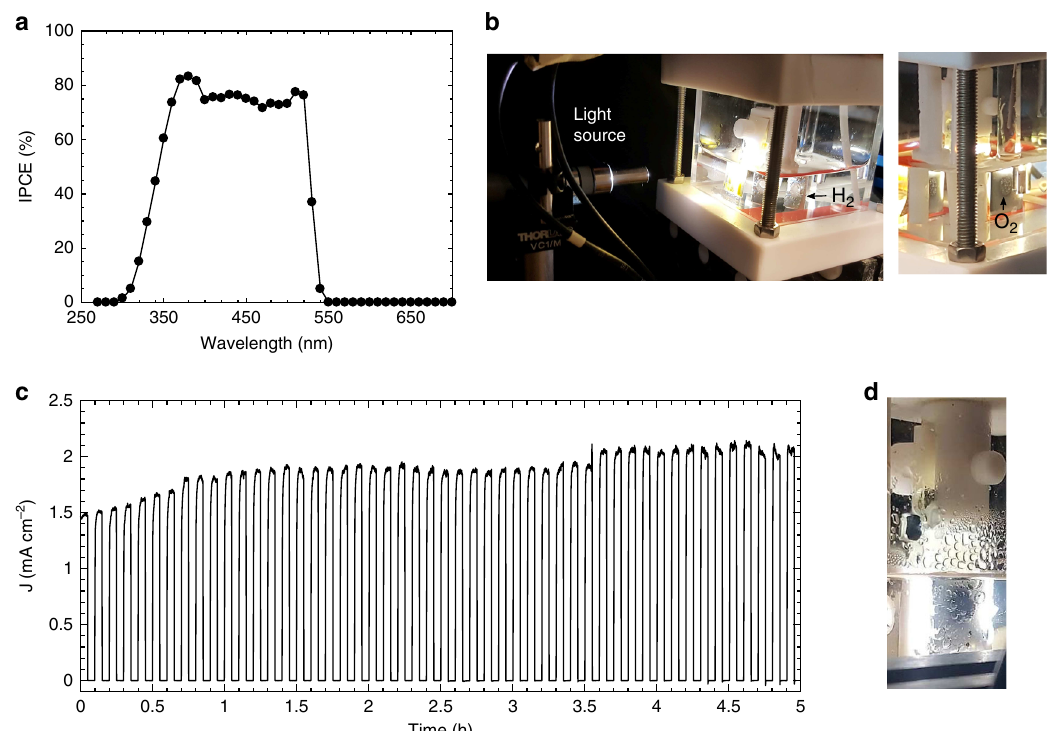
Fig. 3 TiO 2 |CsPbBr 3 |m-c|GS PEC performance in water. a Incident photon-to-current ef fi ciency (IPCE) measured in aqueous 0.1 M KNO 3 solution with the pH adjusted to 12 with KOH; electrode was subjected to monochromatic light irradiation at 1.23 V RHE . b Photographs of the PEC cell under operation, showing H 2 and O 2 gas bubbles evolving from the counter electrode (Pt) and the photoanode, respectively. c Chronoamperometric trace recorded at an applied potential of 1.23 V RHE in KOH electrolyte solution at pH 12.5, under chopped simulated solar light irradiation (AM 1.5 G, 100 mW cm − 2 ). d Photographs of the photoanode immersed in the electrolyte solution after 18 h of continuous operation, showing oxygen bubbles evolving from the active